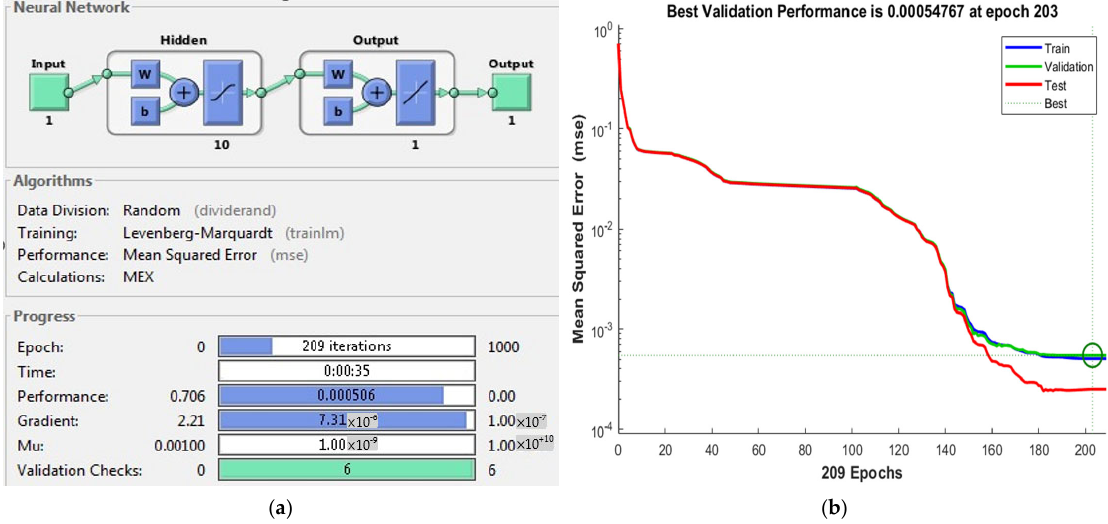
Figure 10. ANN architecture of the torque controller and its evolution formation ( a ) Performance of the mean quadratic error (training, testing, validation) ( b ).